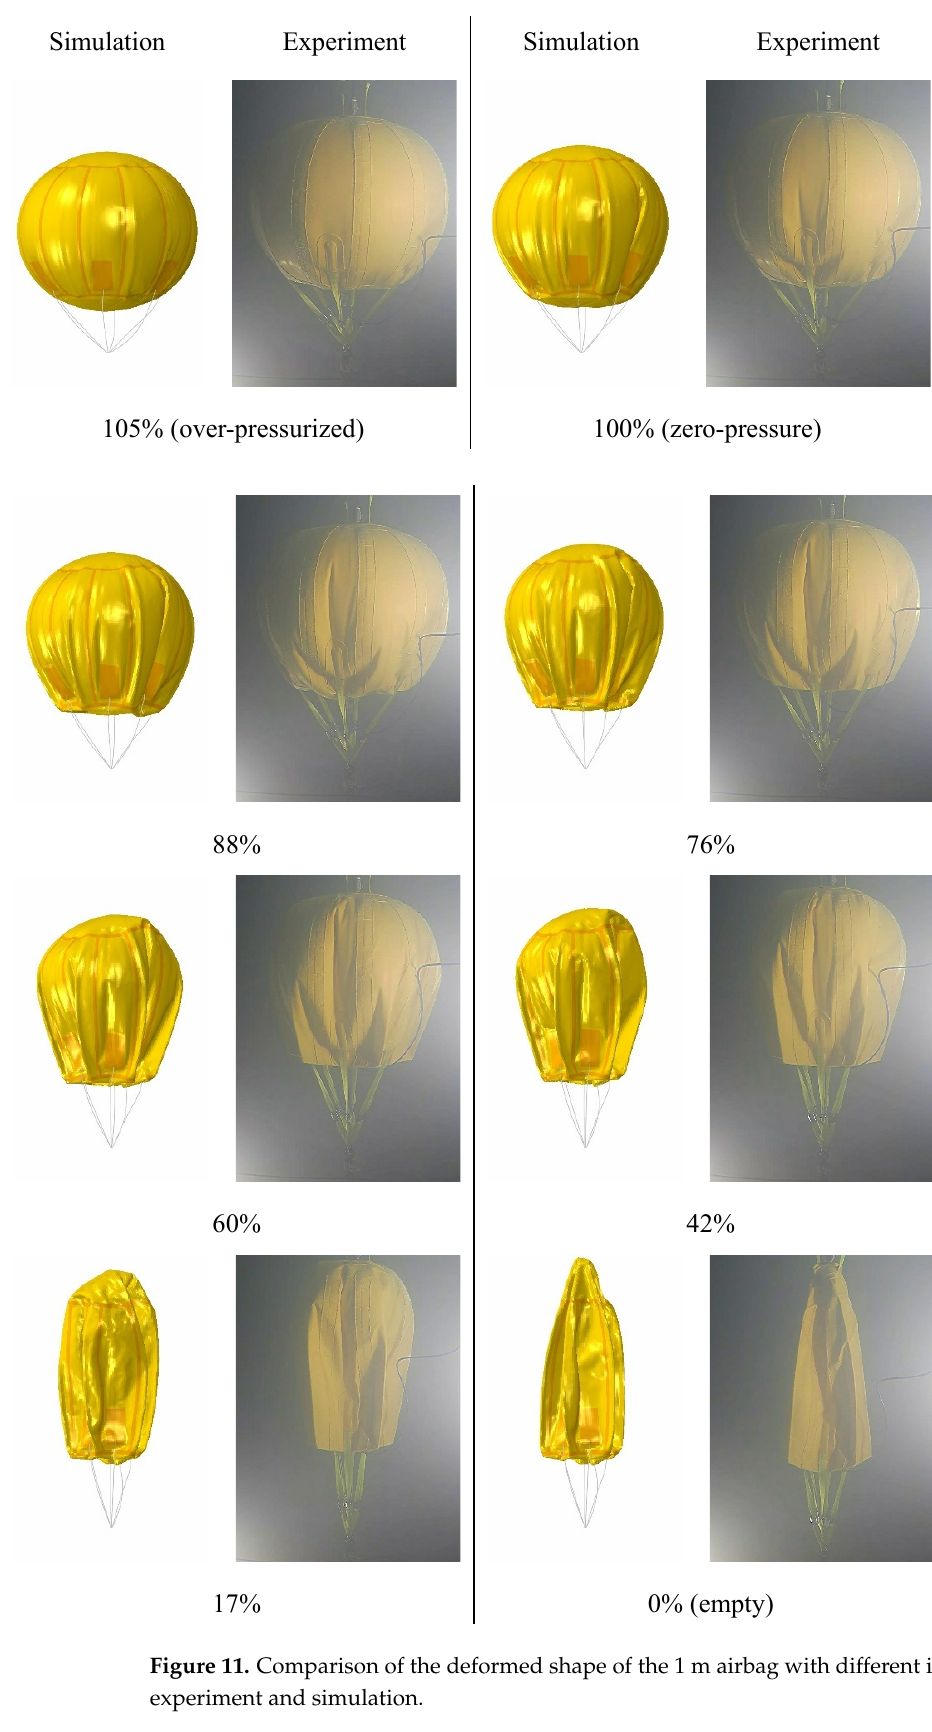
Figure 11. Comparison of the deformed shape of the 1 m airbag with different inflation ratios in the experiment and simulation.